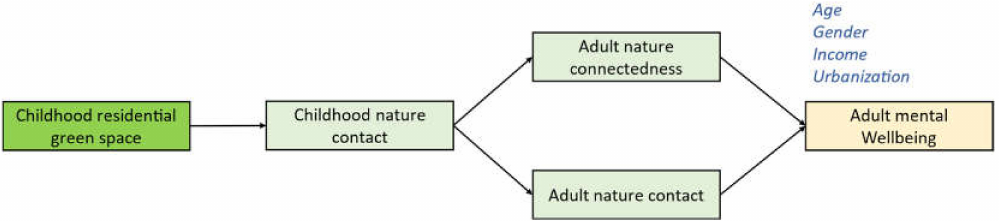
Figure 1. Conceptual framework linking childhood residential green space to adult mental